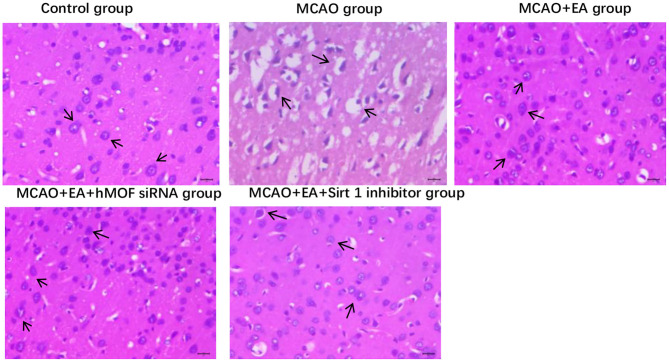
The histopathological findings in the right striatum brain tissue, ×400.